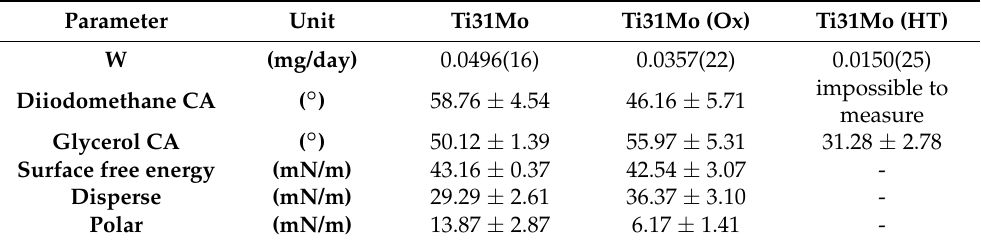
Table 4. Estimated weight loss (W) after 7-days immersing in Ringer solution environment and contact angle (CA), surface free energy, disperse, and polar for Ti31Mo before modification, after NaOH 60 ◦ C/24 h and hydrothermal